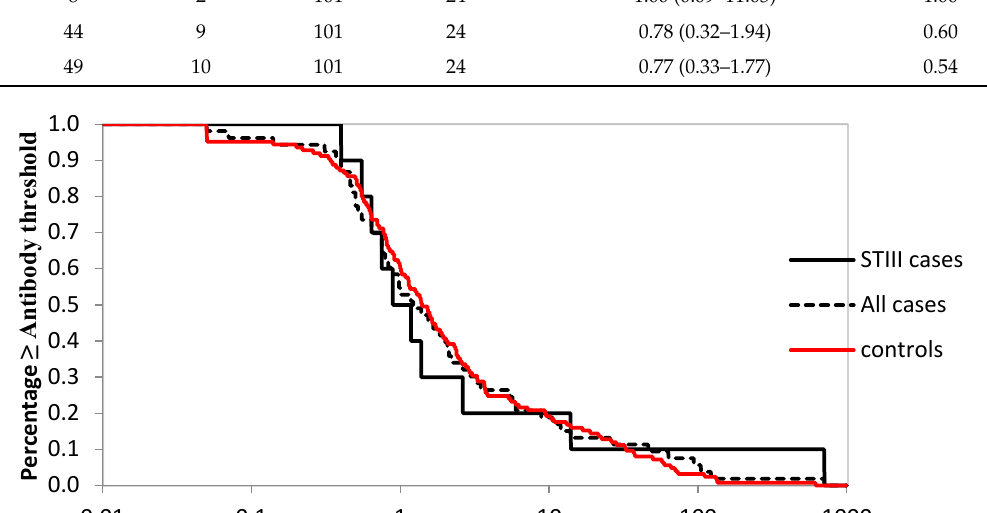
Figure 3. Reverse cumulative distribution curve of serotype III antibodies. The distribution of concentration of maternally transferred GBS specific serotype III antibodies from DBS blood samples of infants born in England. Note that the RCD curve for all cases except those serotyped as not serotype III is very similar to the serotype III cases curve.